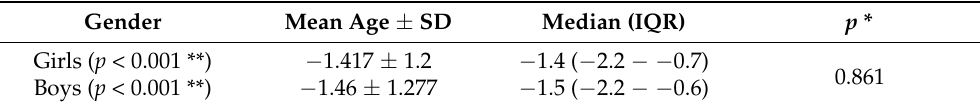
Table 4. Chronological age, dental age, and differences between the two for girls and